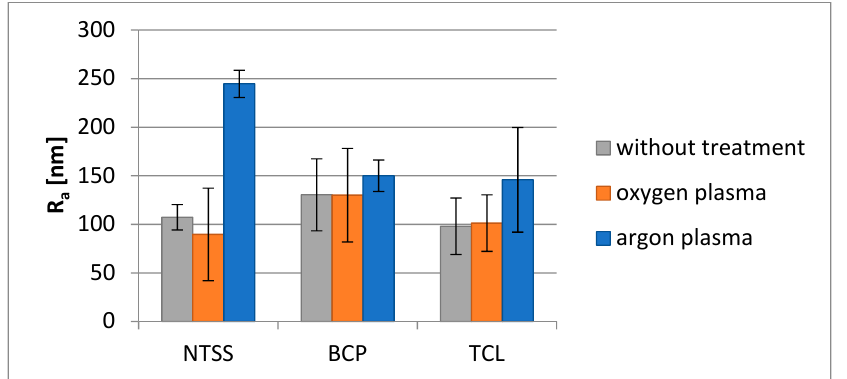
Figure 3. Film roughness before and after plasma activation.